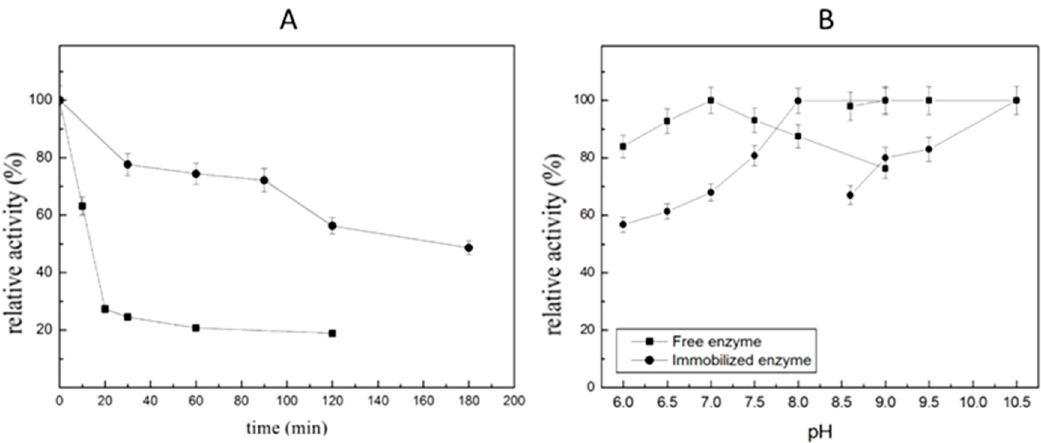
Figure 4. The thermal and pH stability of free and immobilized ST2570CQ: ( A ) The thermal stability of free and site-specific immobilized ST2570CQ; ( B ) The pH stability of free and immobilized ST2570CQ. ( ■ ) free enzyme ( ● ) immobilized enzyme; 50 mM PB buffer (pH 6.0–9.0) and 50 mM Gly-NaOH buffer (pH 8.6–10.5). All the immobilized enzymes used were prepared with the optimal conditions described at the end of Section 2.4. The conditions for the activity assay were constant stirring at 110 rpm for 5 min in 70 °C water-bathing constant temperature vibrator. Three trials were performed for each test.